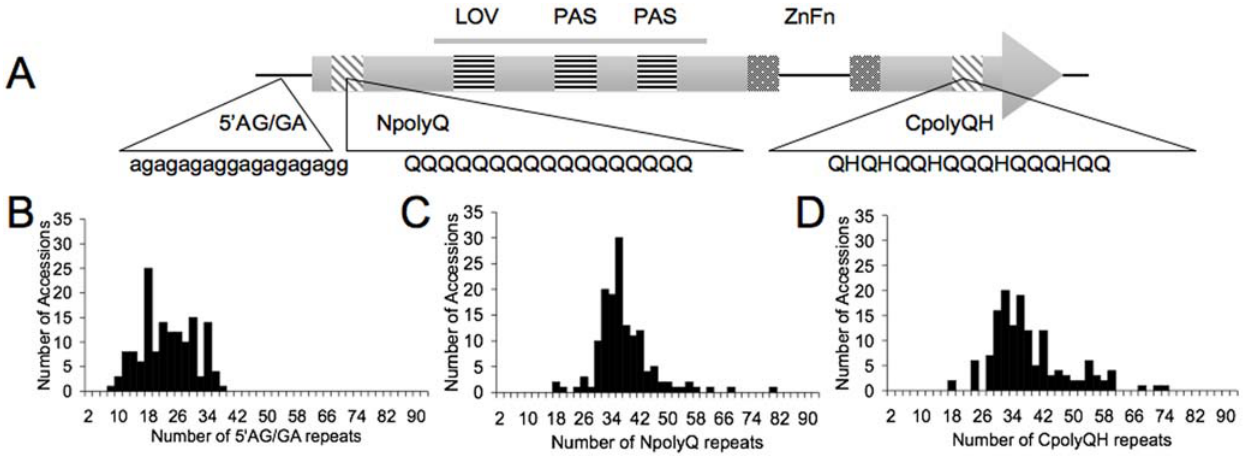
Figure 3. Extensive genotypic variation in WC-1 SSR. (A) The wc-1 gene contains a 5 9 UTR, an intron, a 3 9 UTR (solid line) and two exons (boxes). WC-1 protein structure: AD, activation domain (striped boxes); LOV, light, oxygen and voltage domain (horizontal line boxes); PAS, PER-ARNT-SIM domain (horizontal line boxes); ZnFn, GATA-type zinc transcription factor DNA binding domain (grey dotted boxes). The number WC-1 5 9 AG/GA (B), NpolyQ (C) and CpolyQH (D) repeats were estimated across 143 N. crassa accessions (Materials and Methods). Repeat number was confirmed by sequencing the repeats in multiple accessions (Figure S1 and Table S1).